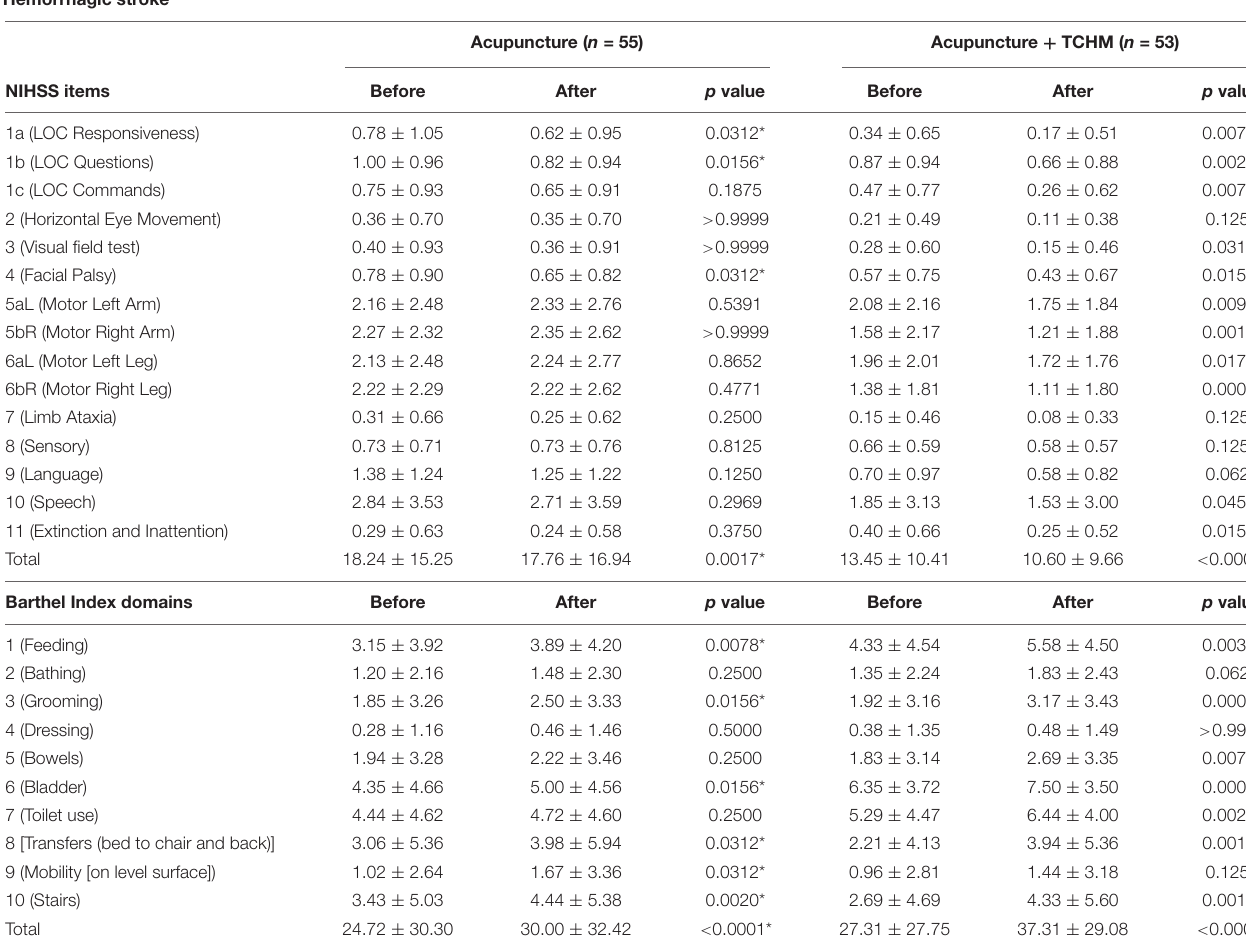
TABLE 2 | NIHSS and Barthel Index scores in hemorrhagic stroke patients with ITCWM-stroke care. Hemorrhagic